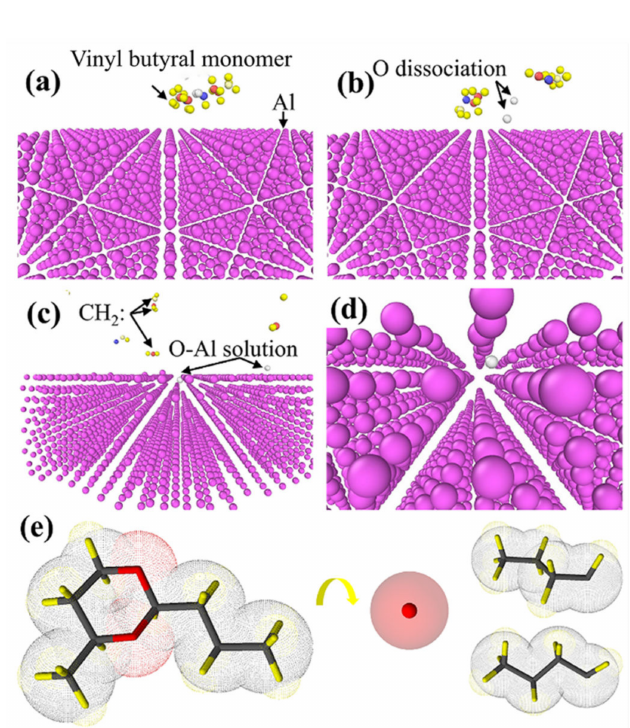
Figure 2. Molecular dynamics simulation of the reaction between vinyl butyral monomer and Al particles: ( a ) initial model of the vinyl butyral monomer and Al particles, ( b ) O atom dissociation process from the vinyl butyral monomer, ( c ) and ( d ) the formation of a solid solution with the Al particles, and ( e ) the actual process of O atom dissociation from the vinyl butyral